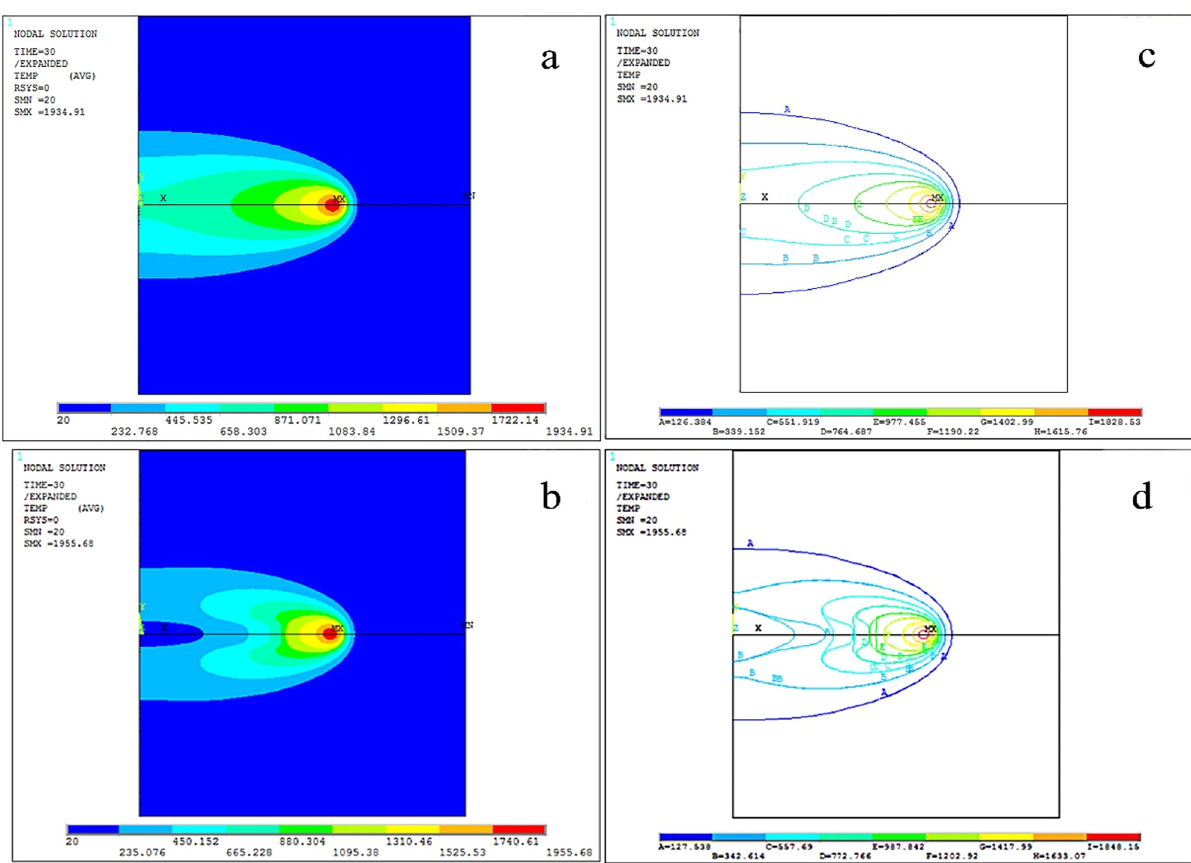
Figure 9: 3D simulated temperature fi elds and isotherms of conventional GTAW and GTAW with trailing cooling source. ( a ) Temperature fi eld of conventional welding; ( b ) temperature fi eld of welding with trailing cooling source; ( c ) isotherms of conventional welding and ( d ) isotherms of welding with trailing cooling source.